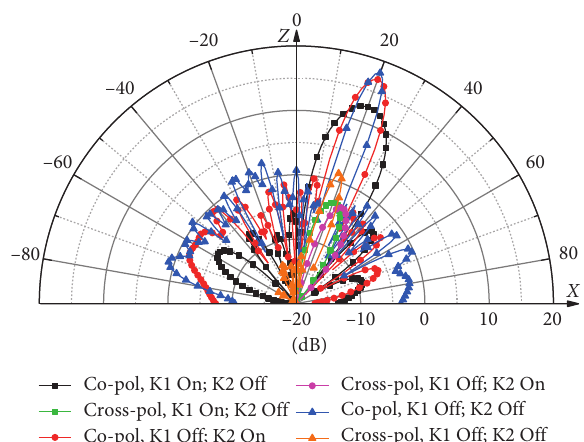
Figure 12: Simulated radiation pattern of the linear irregular FRAA with the beam steering angles of θ xoz � 20 °